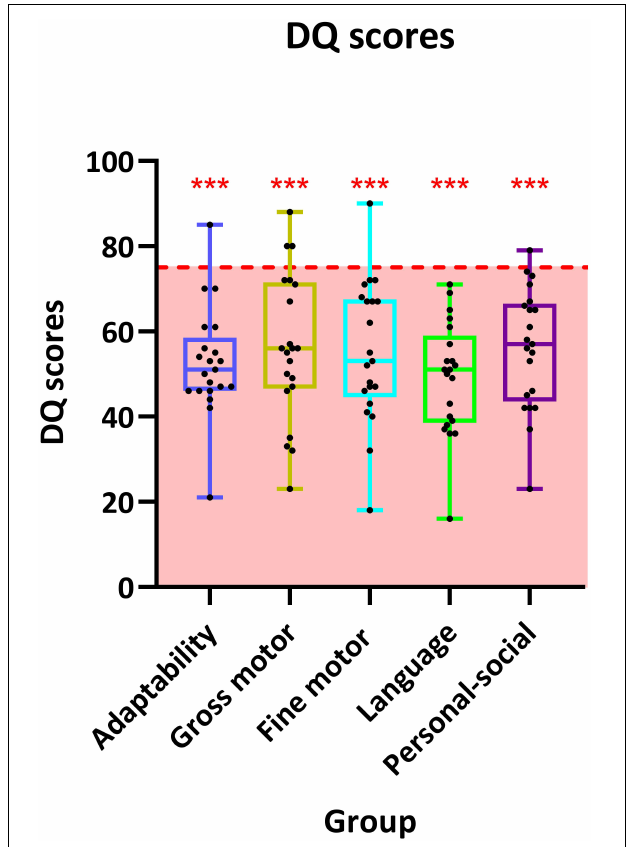
FIGURE 2 | Distribution of developmental quotient (DQ) scores of 19 individuals in the five sub-domains of the Chinese version of Gesell Development Diagnosis Scale (GDDS-C). The interquartile ranges are shown as a box-and-whisker plot. For one-sample t -test, the critical value is 75 (*** represents p <